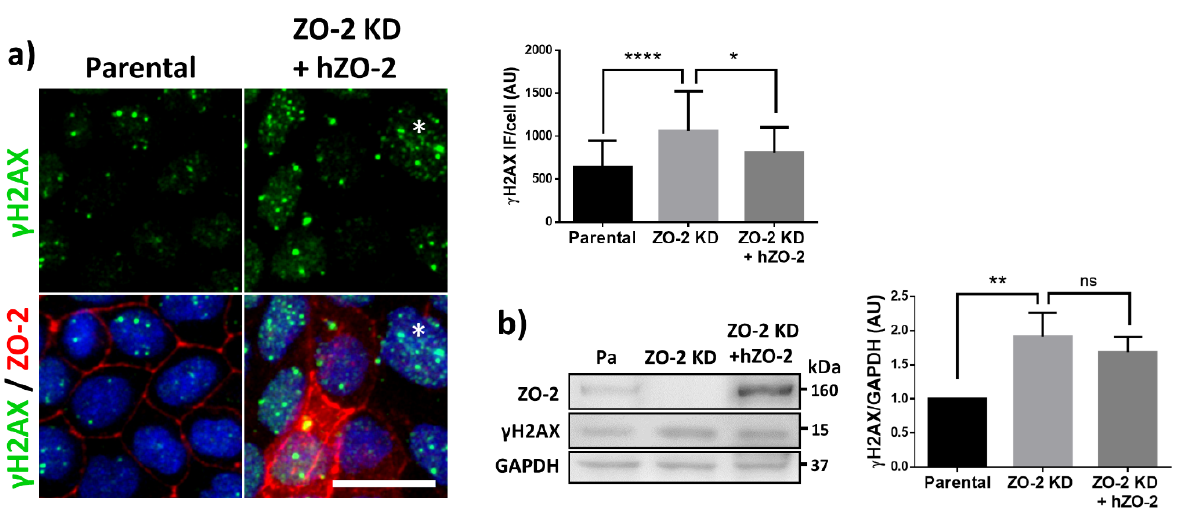
Figure 2. ϒ -H2AX nuclear foci are more abundant in ZO-2 KD than in parental MDCK cells. ( a ) Parental and ZO-2 KD MDCK cells transfected or not with hZO-2 were processed for immunofluorescence with an antibody against ϒ -H2AX, a DDR marker. Cell borders were stained with antibodies against ZO-1, and the nuclei were detected with DAPI. Left, representative images, bar 20 µ m; *, non-transfected cell. Right, quantitative analysis done with ImageJ. Data obtained from at least 38 cells derived from three optical fields in each experimental condition: parental cells, MDCK ZO-2 KD cells highly expressing transfected hZO-2, and ZO-2 KD cells without visible transfected hZO-2 signal. Statistical analysis was done with Kruskal-Wallis followed by Dunn’s multiple comparisons test. Results are shown as media ± standard deviation. * p < 0.05, **** p < 0.0001. ( b ) Western blot detection of ϒ -H2AX in Parental and ZO-2 KD MDCK cells transfected or not with hZO-2. GAPDH was employed as a loading control. Left panel, representative Western blot; right panel, quantitative analysis of three independent experiments. Statistical analysis was done with one-way ANOVA, followed by Tukey’s multiple comparisons test. Results are shown as media ± standard deviation, ** p < 0.01; ns, non-significant.